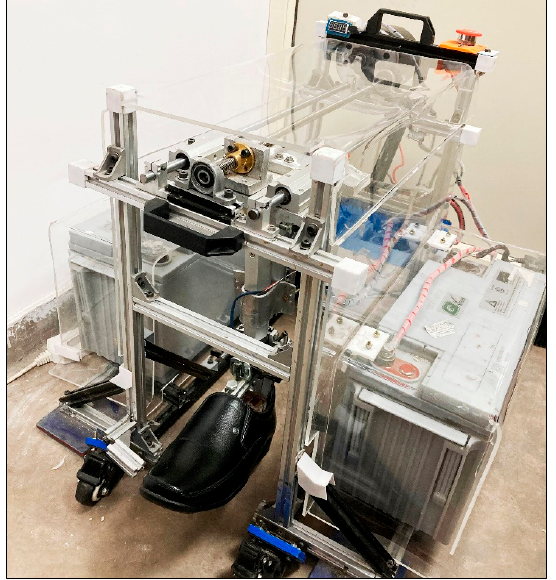
Figure 3. Whole-shoe portable slip testing device